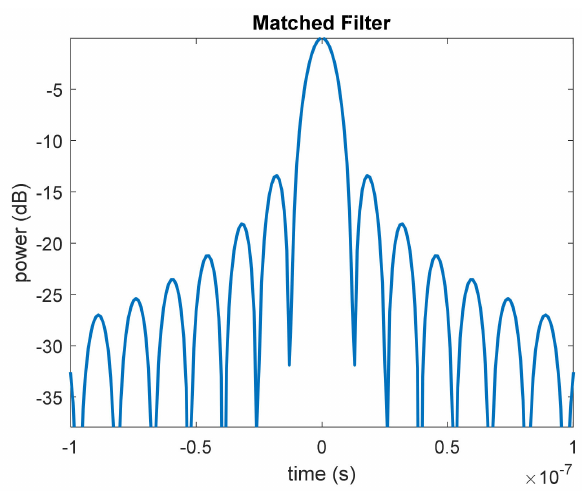
Figure 10. Example of matched filter output for the ideal linear frequency-modulated (LFM) signal used in our 2D tomographic simulations. Pulse width is 1 us, time resolution is 1 ns, and bandwidth is 80 MHz. No windowing has been applied.